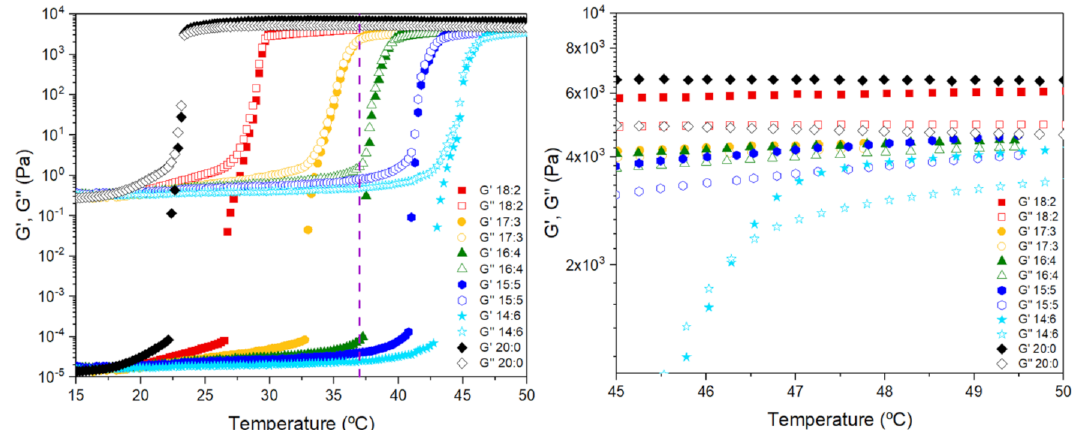
Figure 1. Elastic (G (cid:48) ) and viscous (G (cid:48)(cid:48) ) moduli of different ratios of Pluronic F127 and F68, of a Pluronic aqueous solution of 20% (wt.%) ( left ). The violet line represents 37 ◦ C. On the ( right ), there is an approximation of the region between 45 and 50 ◦ C of the image on the